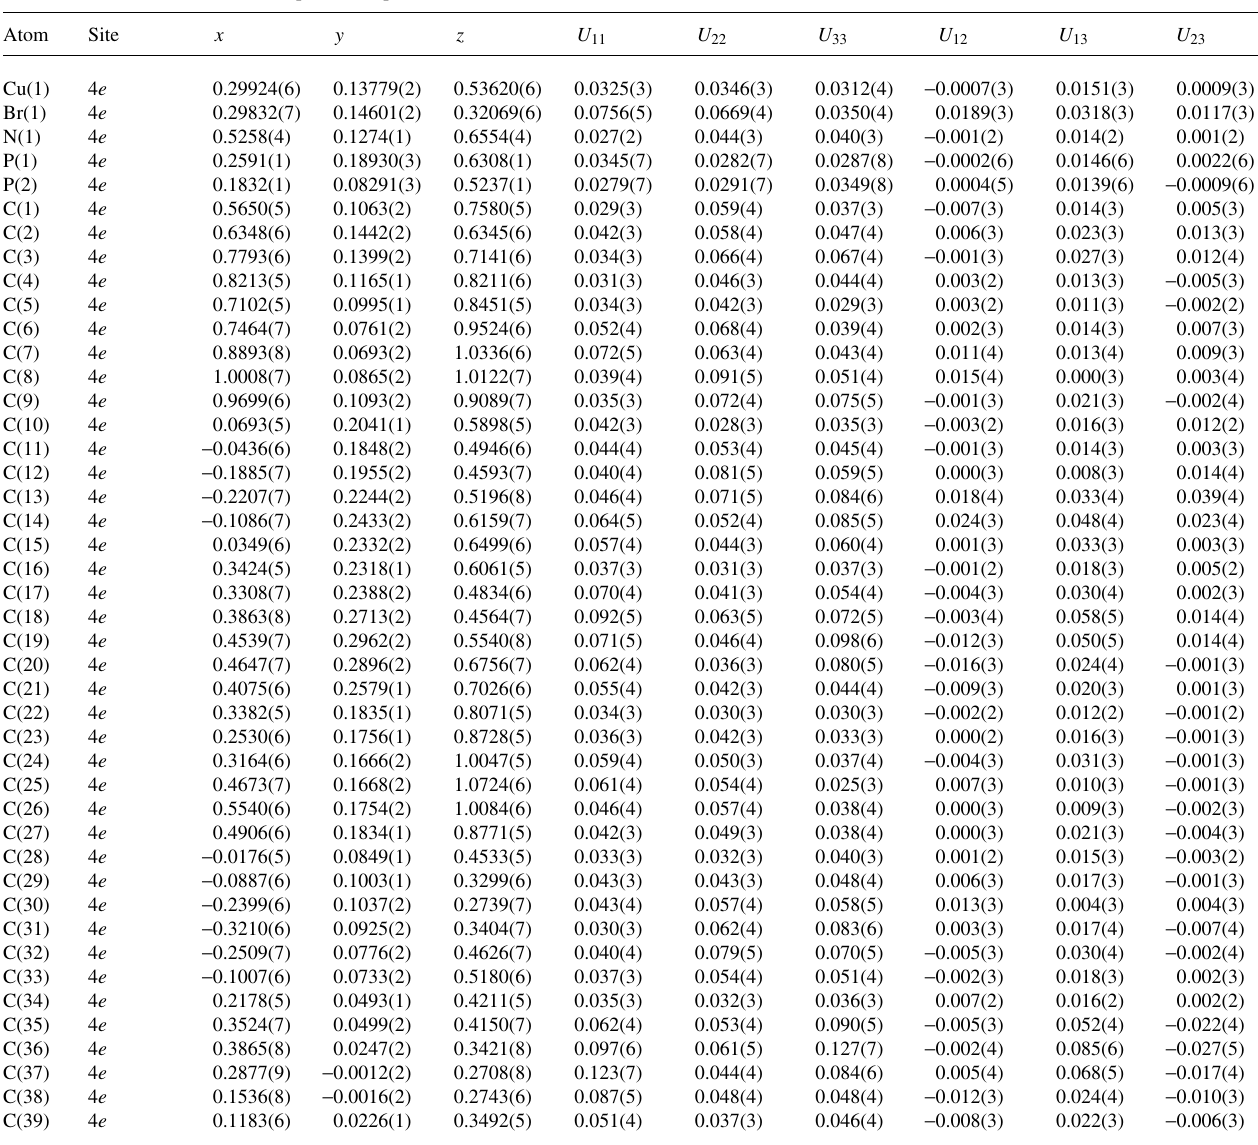
Table 3. Atomic coordinates and displacement parameters (in Å 2 ) .